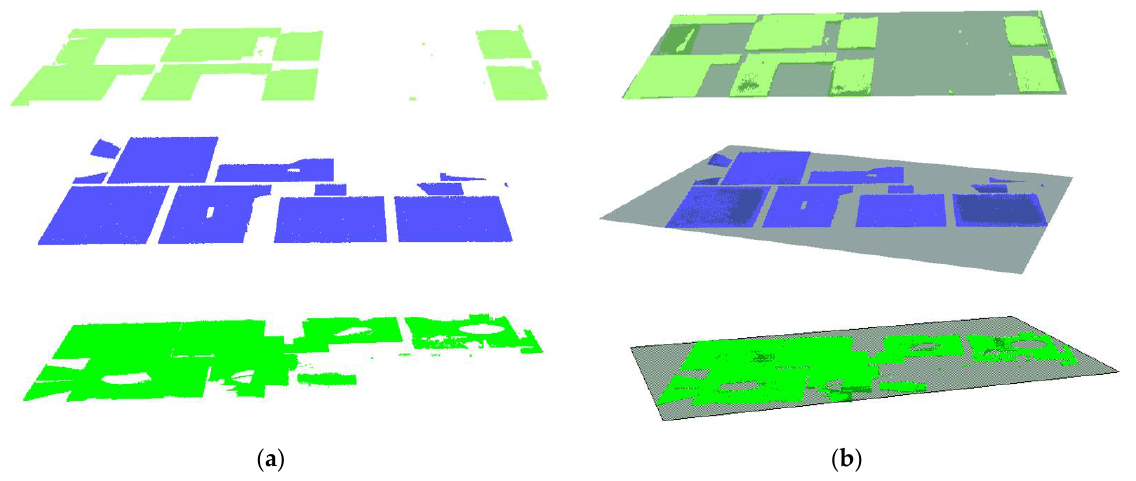
Figure 17. Results of spanning the horizontal principal planes and the subsequent assignment of disconnected coplanar patches: ( a ) disconnected principal patches; ( b ) planes fitted after spanning the principal patches and assigning the corresponding coplanar patches.